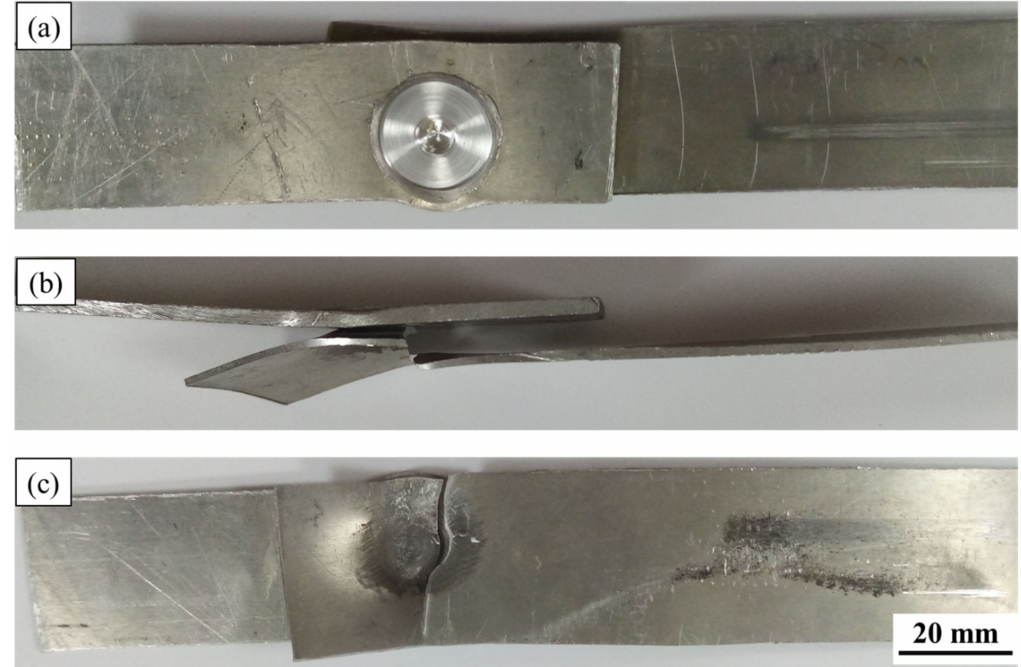
Figure 18. ( a ) top view, ( b ) side view, and ( c ) bottom view photographs of the fracture surface appearance of the FSSWed lap joint processed at 600 rpm and 3